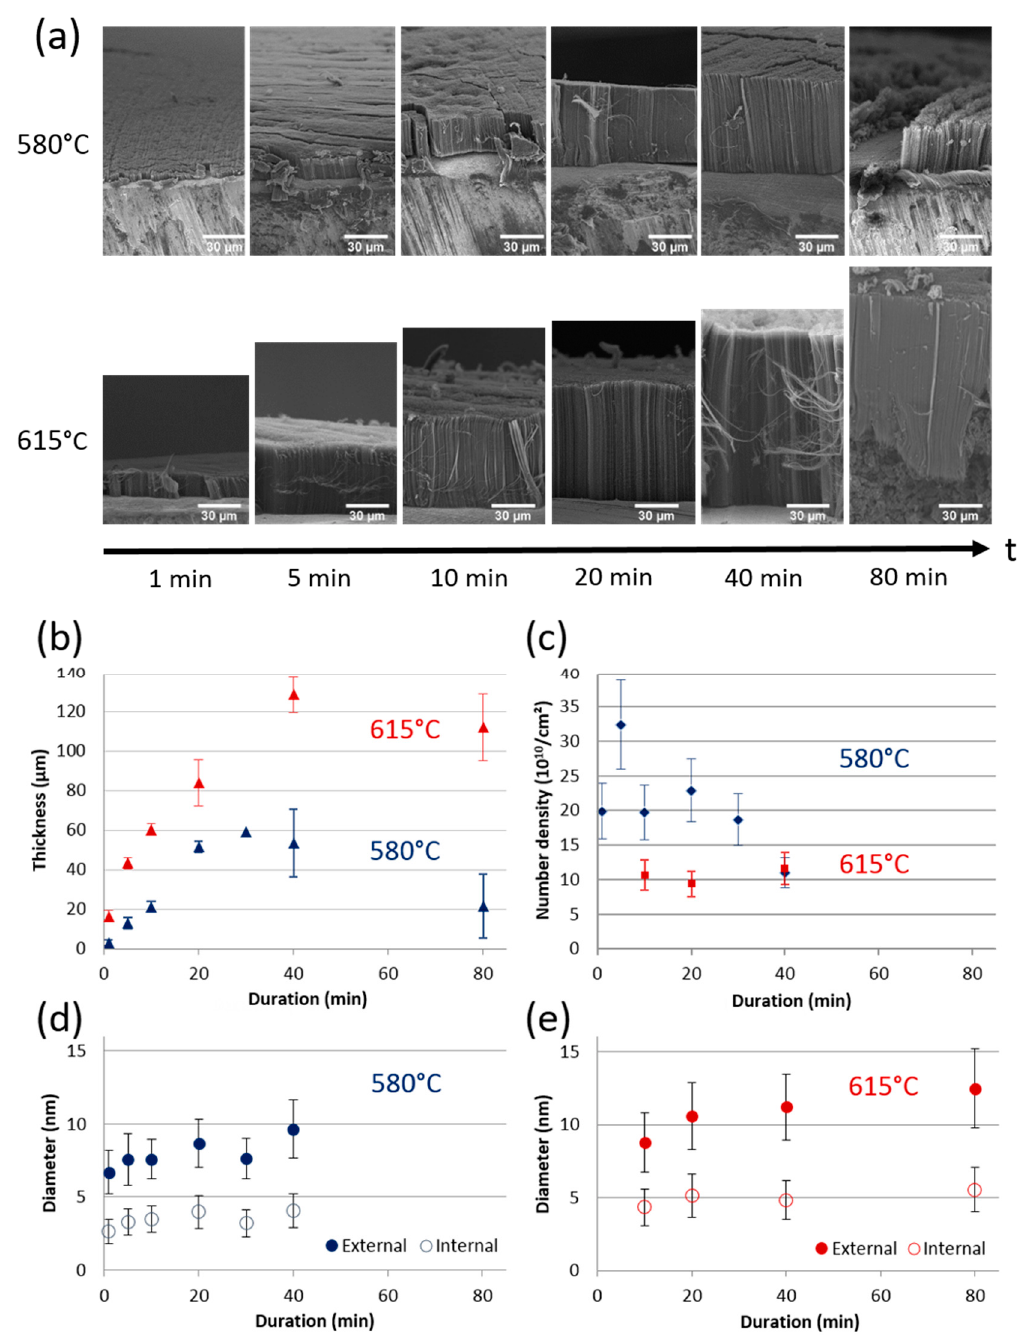
Figure 4. ( a ) SEM images of VACNT carpets obtained at 580 and 615 °C for increasing synthesis duration. Influence of synthesis duration on ( b ) carpet thickness, ( c ) CNT number density and ( d , e ) external and internal CNT diameters and their standard deviations at 580 and 615 °C, respectively.